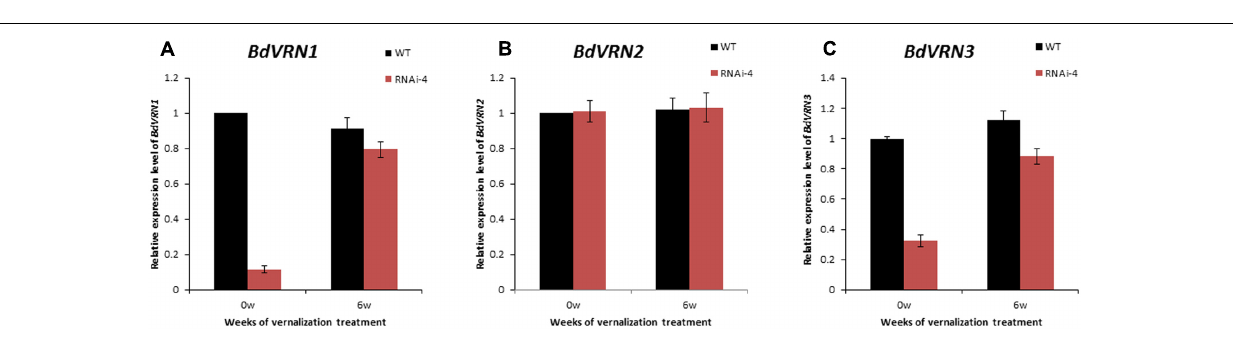
FIGURE 4 | Expression analysis of BdVRN1 (A) , BdVRN2 (B) , and BdVRN3 (C) genes in the WT (Bd21) and BdVRN1 RNAi mutant. The relative expression levels of each gene were determined by Real-Time RT-PCR in leaf tissues. Prior to vernalization, plants were grown at a greenhouse (25 ◦ C, 16/8 h day/night). Four-week-old seedlings were then transferred to a growth chamber at 4 ◦ C (8/16 h day/night) for 0 or 6 weeks. BdGAPDH is a loading control. Error bars represent the standard deviation from independent